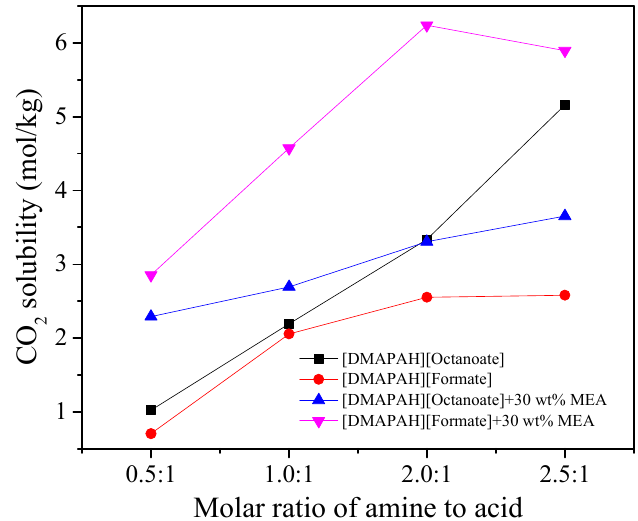
Figure 2. E ff ects of MEA on CO 2 solubilities in [DMAPAH][Formate] and [DMAPAH][Octanoate] [30]. Figure 2. Effects of MEA on CO 2 solubilities in [DMAPAH][Formate] and [DMAPAH][Octanoate] Copyright 2018 [30]. Copyright 2018 Elsevier.